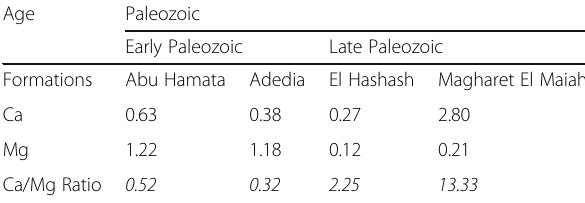
Table 4 SiO 2 /Al 2 O 3 ratio of the studied Paleozoic mudrocks